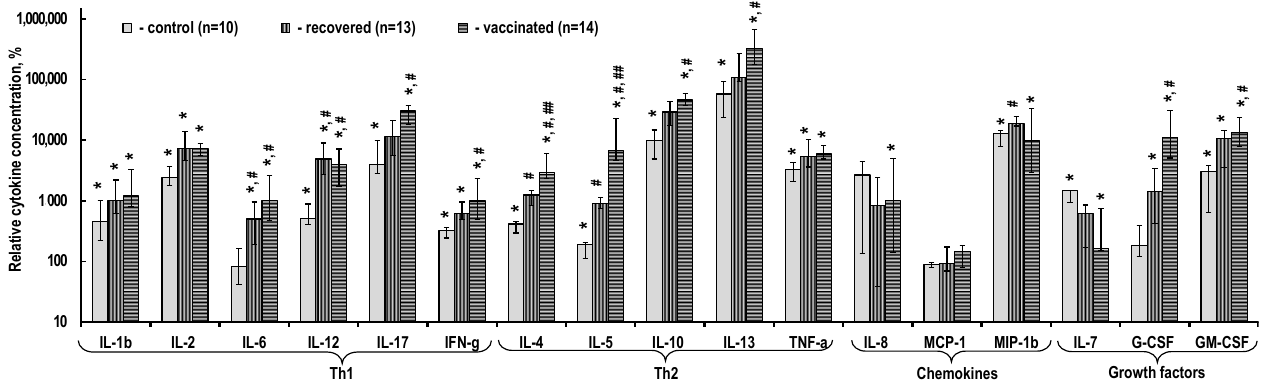
Figure 5. Cytokine content in the PBMC culture medium with non-specific stimulation by OKT3. The relative cytokine concentration is the ratio of the measured absolute concentration of a cytokine in a sample to the median absolute concentration of this cytokine in samples without PBMC stimulation in this group of individuals. * p < 0.01 when comparing samples without stimulation to samples with non-specific stimulation within a group. # p < 0.01 when comparing samples with non-specific stimulation between the group of interest and control group. ## p < 0.01 when comparing samples with non-specific stimulation between the groups of vaccinated and recovered individuals. The data are presented as Me (Q1;